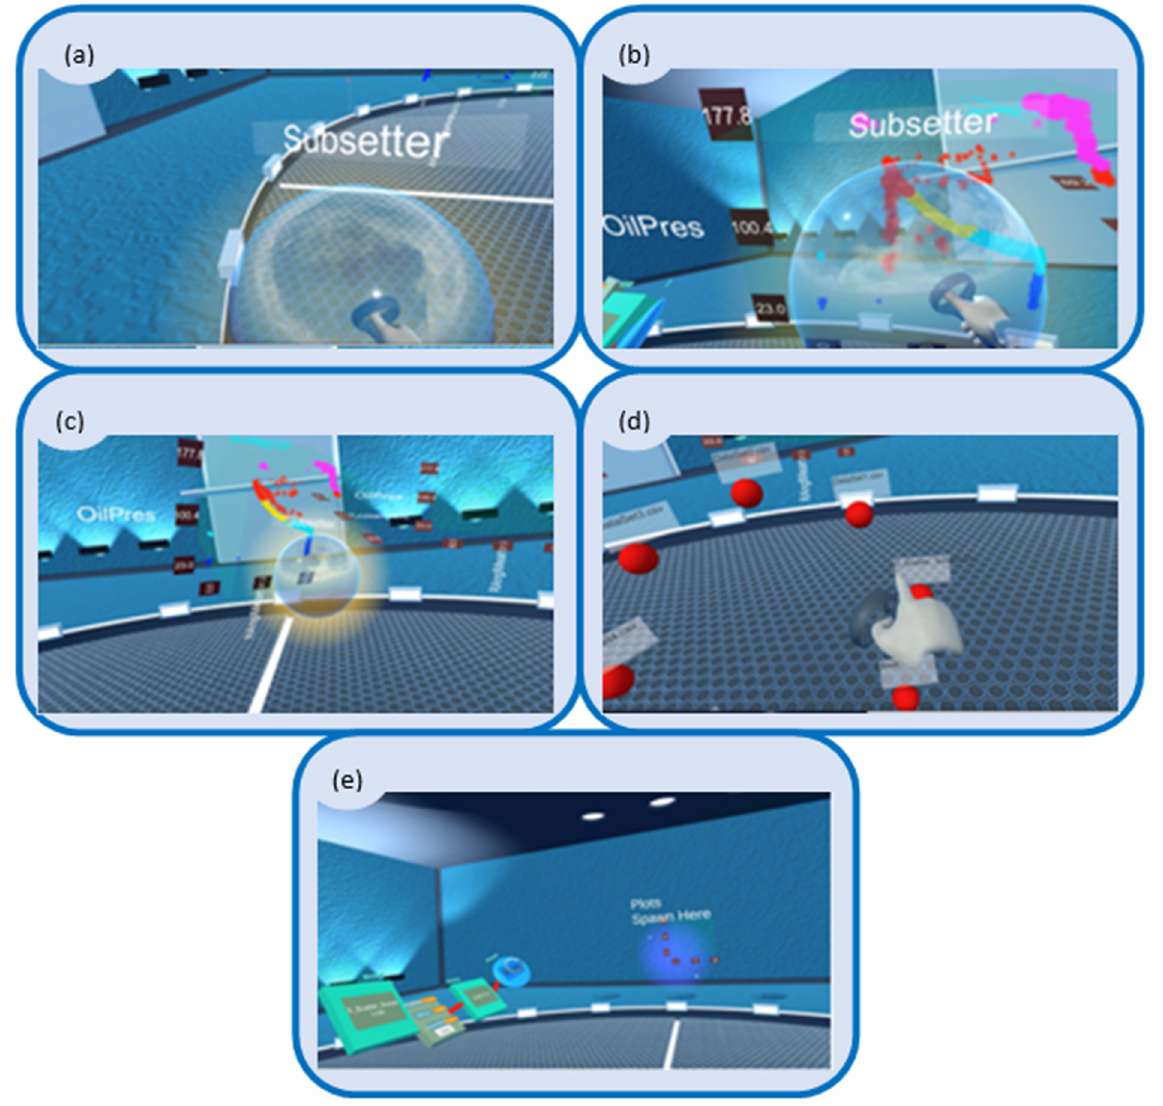
Figure 10. Lasso system. ( a ) 3D Lasso sphere. ( b ) Moving the sphere towards the graph. ( c ) Position the sphere into the desired data points. ( d ) Access the new subsetted data using the menu system. ( e ) Visualize the subsetted data.